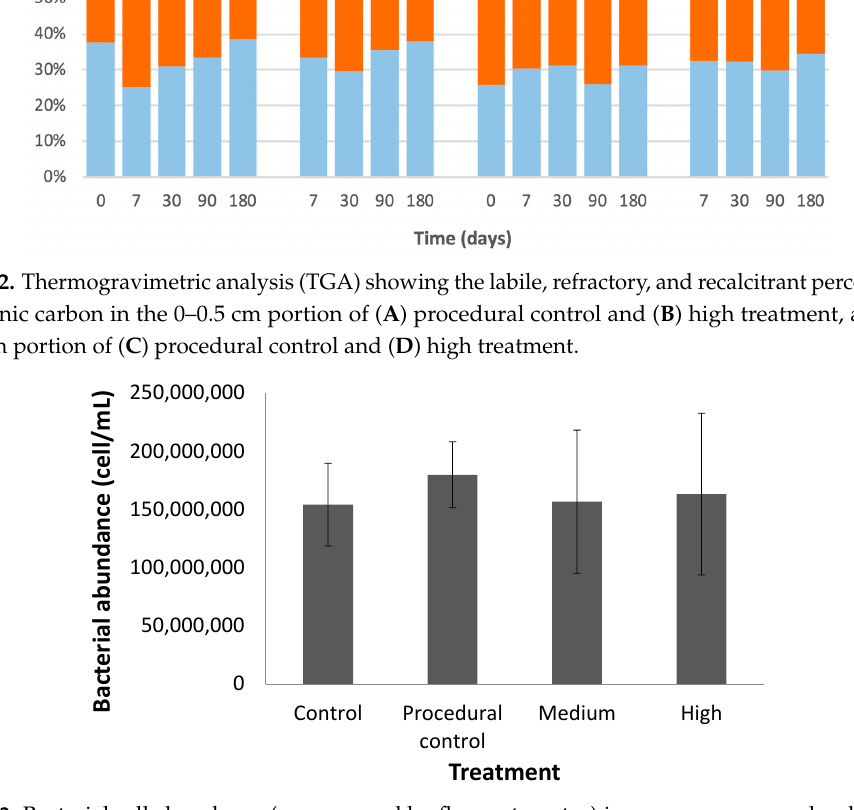
Figure 3. Bacterial cell abundance (as measured by flow cytometry) in seagrass cores under different treatments. Table 1. Results of ANOVA test on the effects of time (7, 30, 90, 180 days), warming treatment (high, medium, low, control, procedural control), and their interactions on the % organic carbon (Corg) and the organic carbon stock within seagrass cores. Significant p -values (<0.05) down in bold.